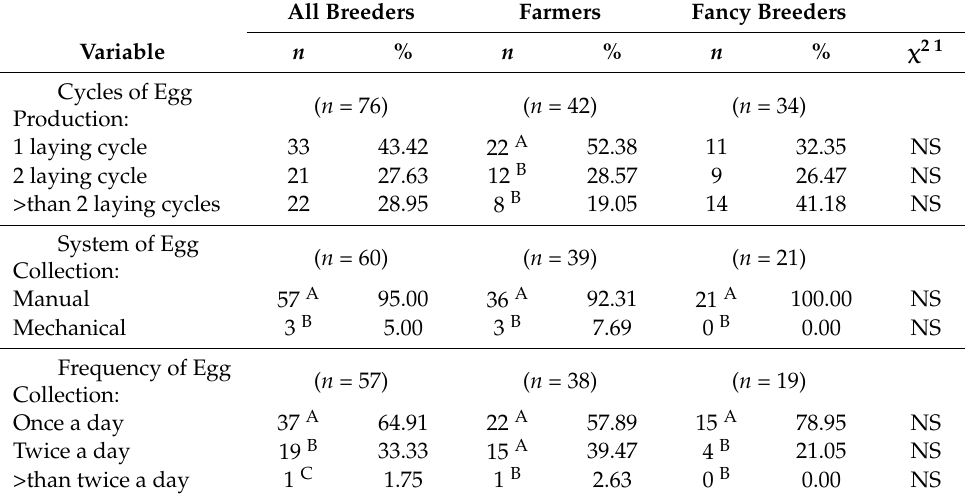
Table 4. Italian chicken breed table egg production characteristics: responses from all breeders and divided according to breeder category.